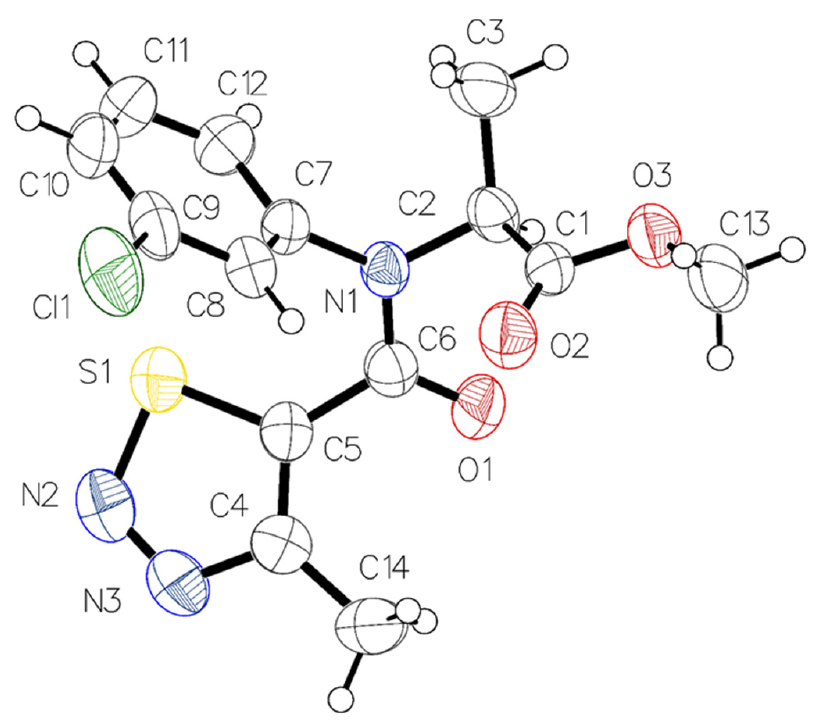
Figure 1. The molecular structure of the compound 1f , showing the atom numbering scheme for the non-H atoms. Displacement ellipsoids are drawn at the 50% probability level. The crystal structure contained molecules of two enantiomers. In enantiomeric pairs, the formation of a C(13)H(13)C . . . O(2) contacts with the following interaction parameters were observed: d (H(13C) . . . O(2)) = 2.478(3) Å, ∠ C(13)H(13C) . . . O(2) = 157.7(3) ◦